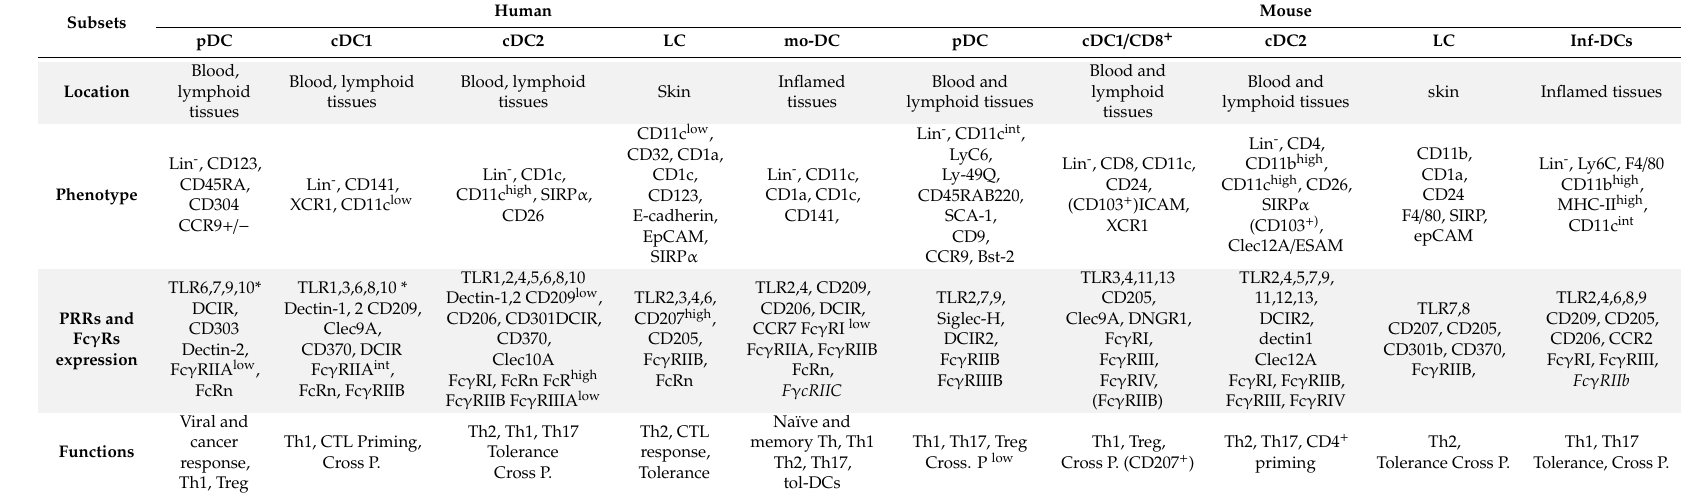
Table 1. Phenotypes and functions of dendritic cells (DC)